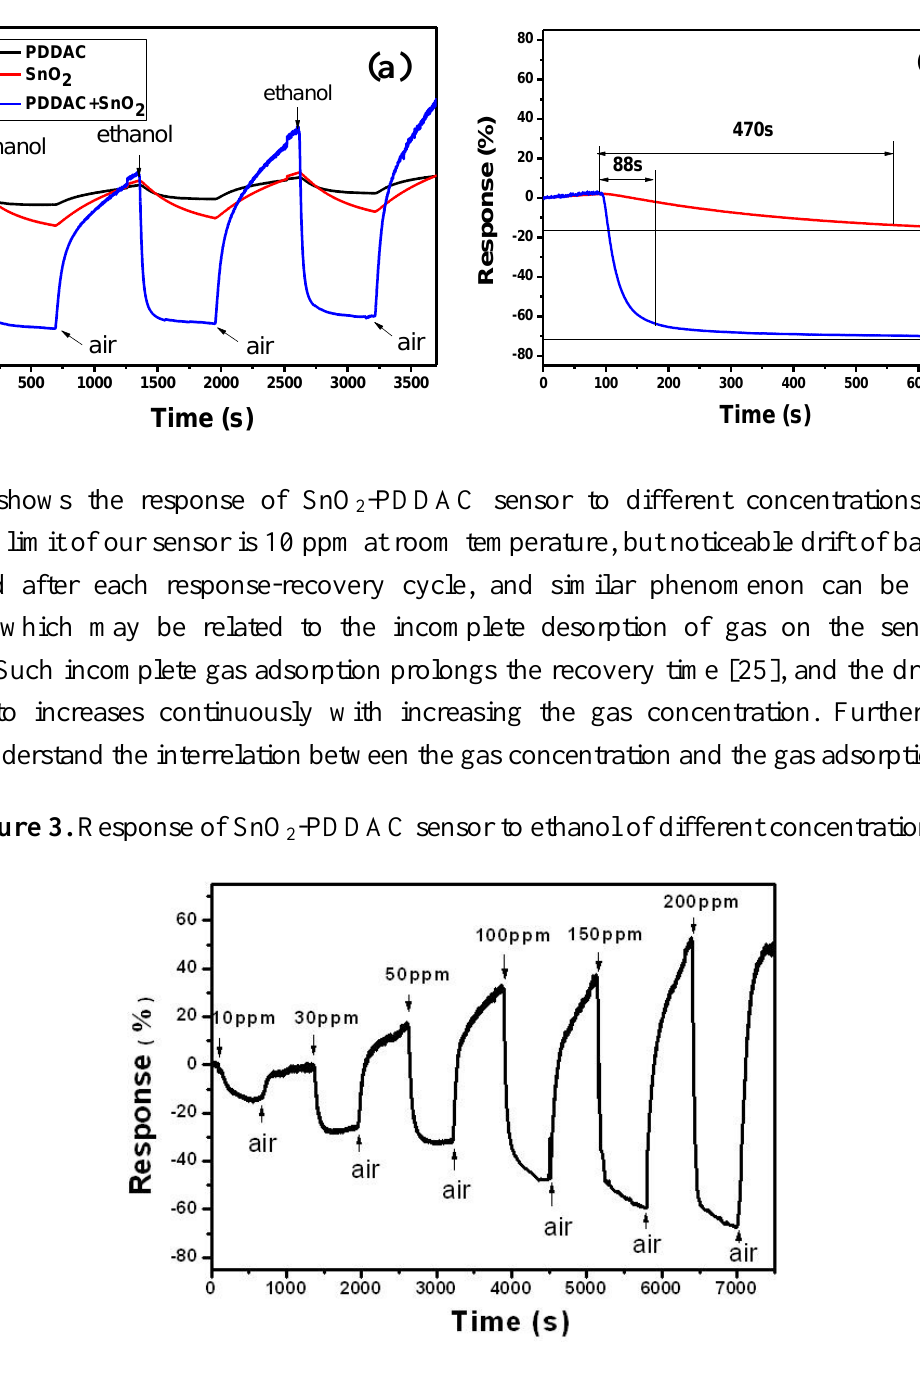
sensor to 150 ppm ethanol at 2 -PDDAC and SnO 2